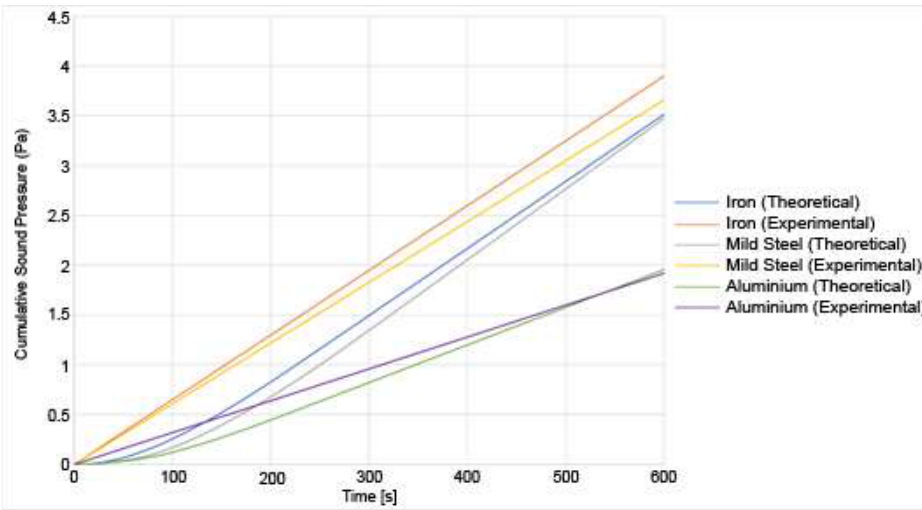
Figure 12. Experimental and theoretical results for the sound generation of varied materials under- going sliding friction under a 20 N load.